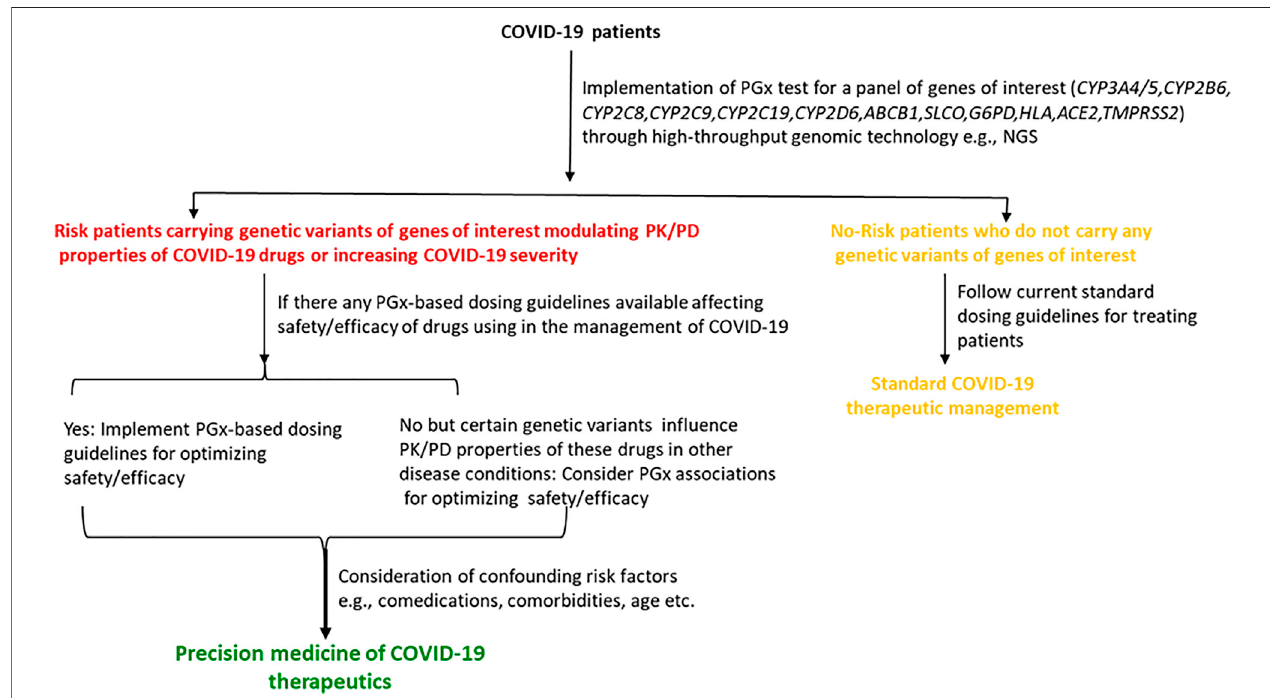
FIGURE 6 | Implementation of precision medicine for drugs used in the management of COVID-19. Here, COVID-19, coronavirus disease-2019; NGS, next- generation sequencing; PK, pharmacokinetics; PD, pharmacodynamics.